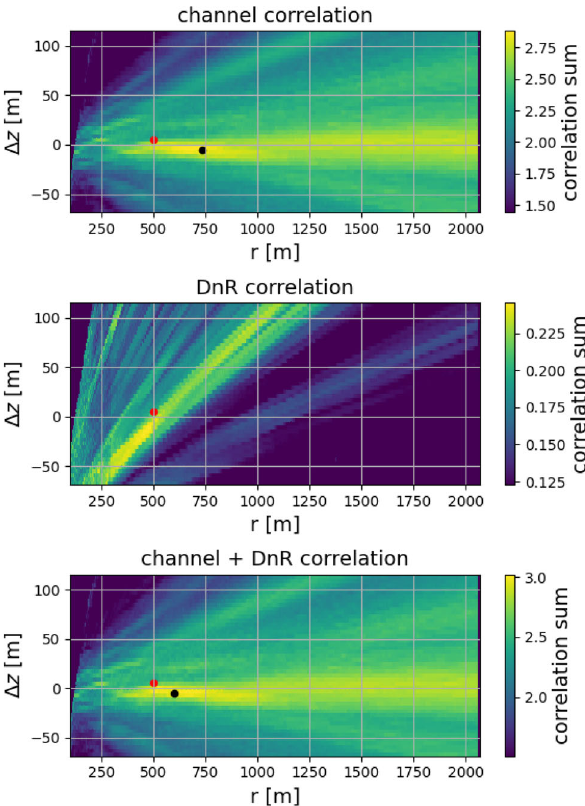
Fig. 7 Use of DnR pulses for vertex reconstruction. Top: Correlation sum using only the correlation products between channels. Middle: Correlation sum using DnR pulses. Bottom: Sum of both correlation between channels and DnR pulse correlation. Results are shown pro- jected into the horizontal distance vs. depth plane, with colors showing the maximum correlation sum over all azimuths. The red dot marks